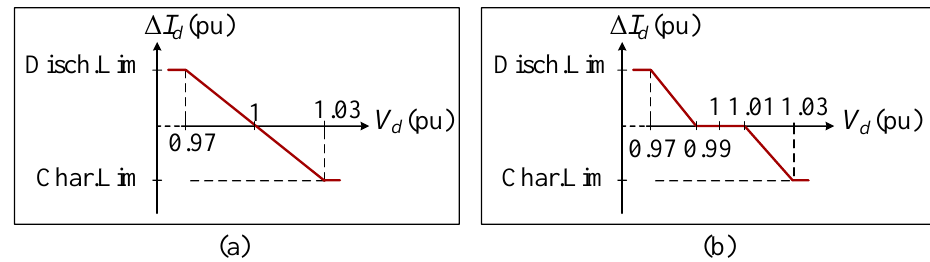
Figure 10. I d -V d droop for control scheme of ES units: ( a ) ES 1 and ( b ) ES 2. 0 . 97